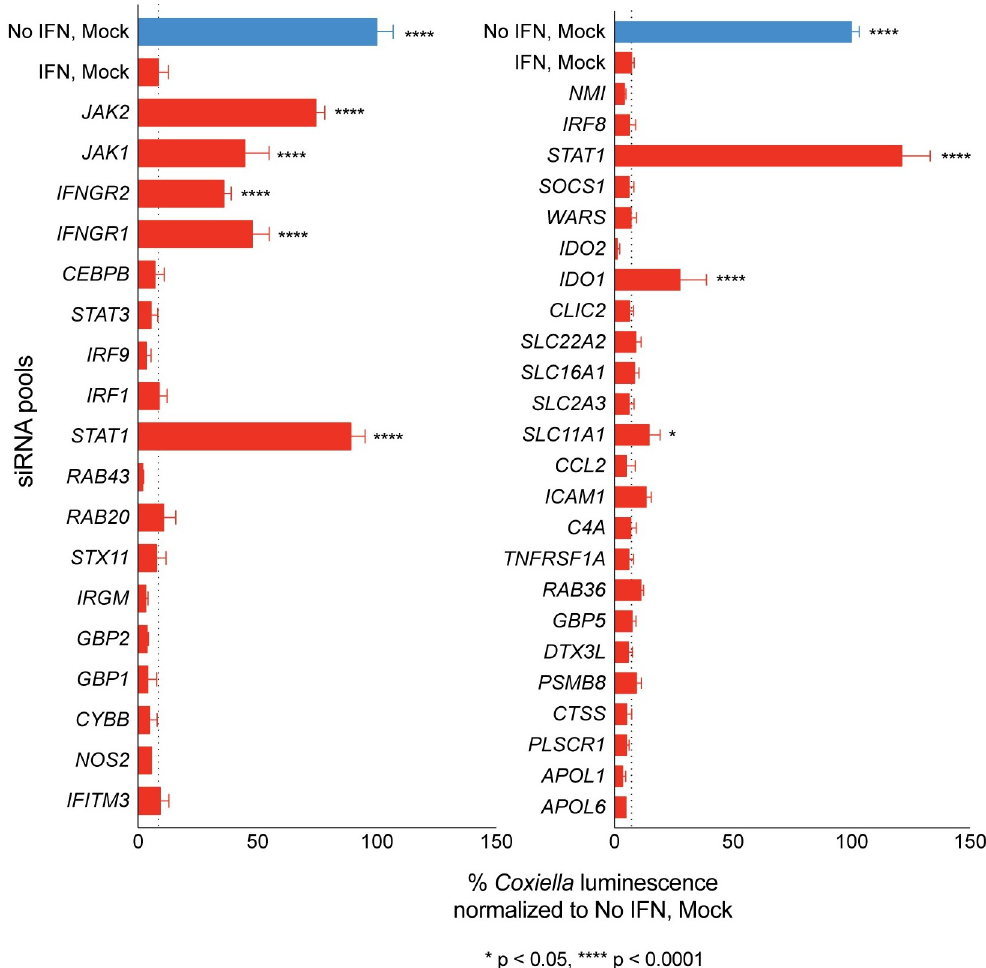
Fig 2. Loss of function analysis of IFN γ -induced genes to identify host factors that mediate restriction of C . burnetii replication. Two panels of selected IFN γ -induced genes were silenced by siRNA in HeLa cells. Cells were infected with C . burnetii lux and left untreated (blue bars) or treated with IFN γ (red bars) at 6h pi. Luminescence values measured on d4 pi were normalized to that of untreated, mock-transfected cells (blue bars). Genes that function in the IFN γ signaling pathway (IFN γ receptors, JAK kinases and the STAT1 transcription factor) were included as positive controls. Dotted lines indicate % luminescence values for mock-transfected, IFN γ -treated cells, which was used as the baseline to calculate statistical significance for each